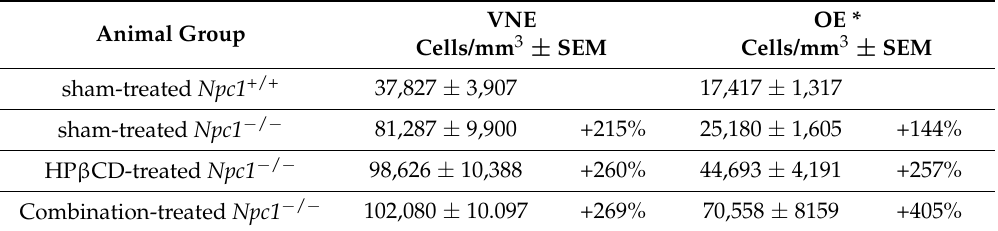
Table 1. Summary of the mean values ± SEM in cells/mm 3 of the cell densities of proliferating BrdU(+) cells in the vomeronasal